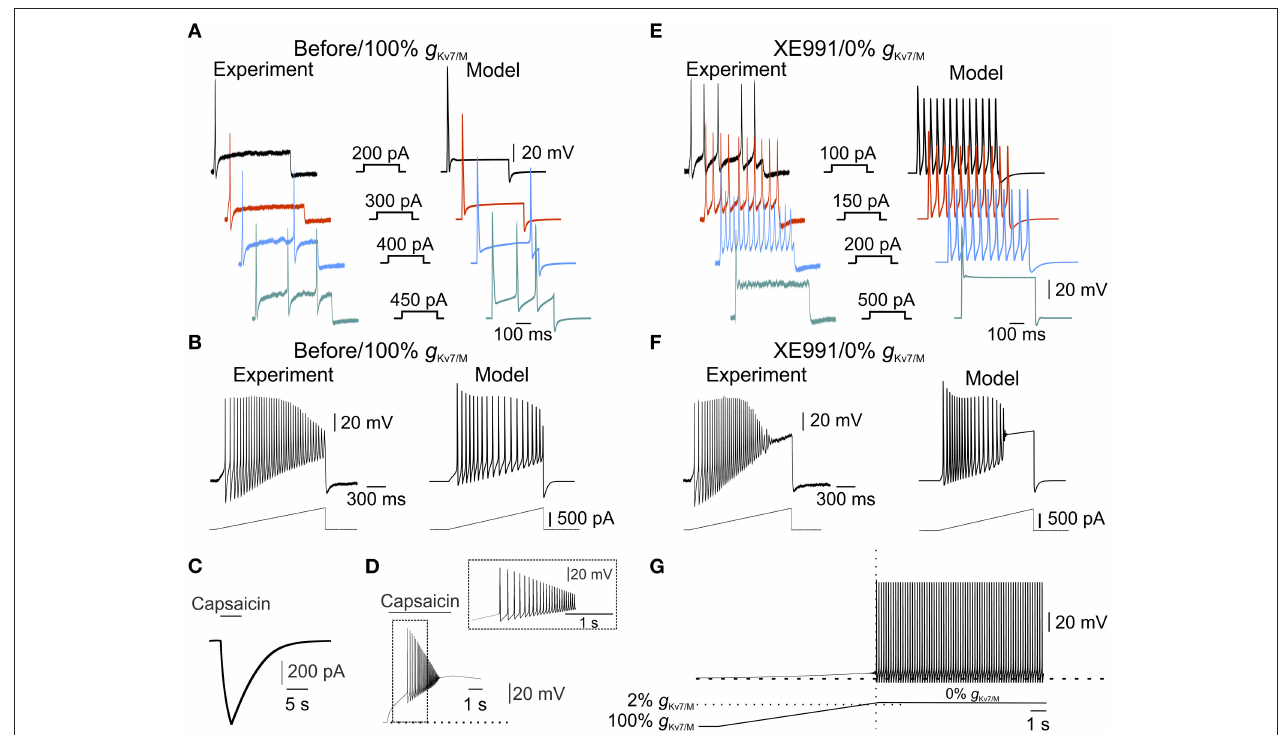
FIGURE 3 | I M is sufficient to prevent spontaneous firing. (A) Typical voltage responses to increasing current steps (showed in the middle panel ) recorded from nociceptor-like cultured DRG neuron using perforated-patch, in current clamp mode ( left ) or from a single-compartment model ( right , see Methods). Recordings were performed on the same DRG neuron before and after application of XE991 (shown in (E) , left ). Traces from the model were obtained using the model with intact g Kv7 / M . Note the similarity between the simulated to experimental responses. (B) Same as in (A) , but showing responses to 1.5s depolarizing current ramps (250 pA/s, showed below ) recorded from nociceptor-like cultured DRG neuron using perforated patch in current clamp mode ( left ) or from the single-compartment model ( right ). Recordings were performed on the same DRG neuron before and after application of XE991 (shown in (F) , left ). Note the similarity between the simulated and experimental responses. (C,D) Validation of the capsaicin-like stimulation on a single compartmental model. (C) Current responses evoked by capsaicin-like stimulation (5s, 1 µ M, see Methods) when applied on a single-compartment model. (D). Capsaicin-like stimulation evokes a barrage of action potentials in the simulated neuron. Dotted line indicates the membrane potentials before the stimulation ( − 57.85mV). (E,F) Voltage responses to increasing current steps ( E , showed in the middle panel ) or current ramps ( F , showed below) recorded from the same neuron shown in (A,B) , 10min after application of 3 µ M XE991 ( left ) or from the simulated neuron with g Kv7 / M = 0 ( right ). All measurements described in panels (E,F) were performed at the native resting potential, adjusted after XE991 application or when g Kv7 / M = 0, by injecting appropriate repolarizing currents. Note that inhibition of I M leads to increase in neuronal excitability which was well reflected in the simulated neuron. (G) Free run recording of membrane potential in a simulated single-compartment modeled neuron during a gradual decrease in g Kv7 / M (the rate of decrease in g Kv7 / M shown below, see Methods). Dashed lines indicate resting potential before changes in g Kv7 / M ( − 57.85mV). The vertical dotted line indicates time of first action potential. Horizontal dashed line indicates the level of g Kv7 / M at which the first action potential occurred. Note that in the simulated neuron, decrease